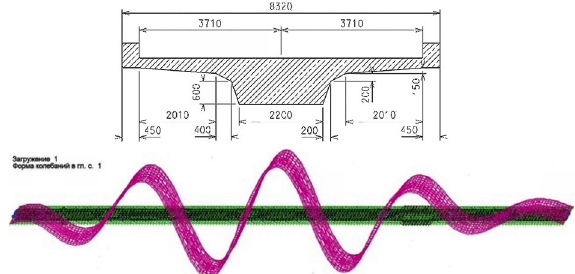
Fig. 7. Cross section and first mode shape of a South bridge overpass Nr. 5–1. FE model constructed as a plate 3D Table 1. Characteristic values of pre-stressed concrete bridges Nr.